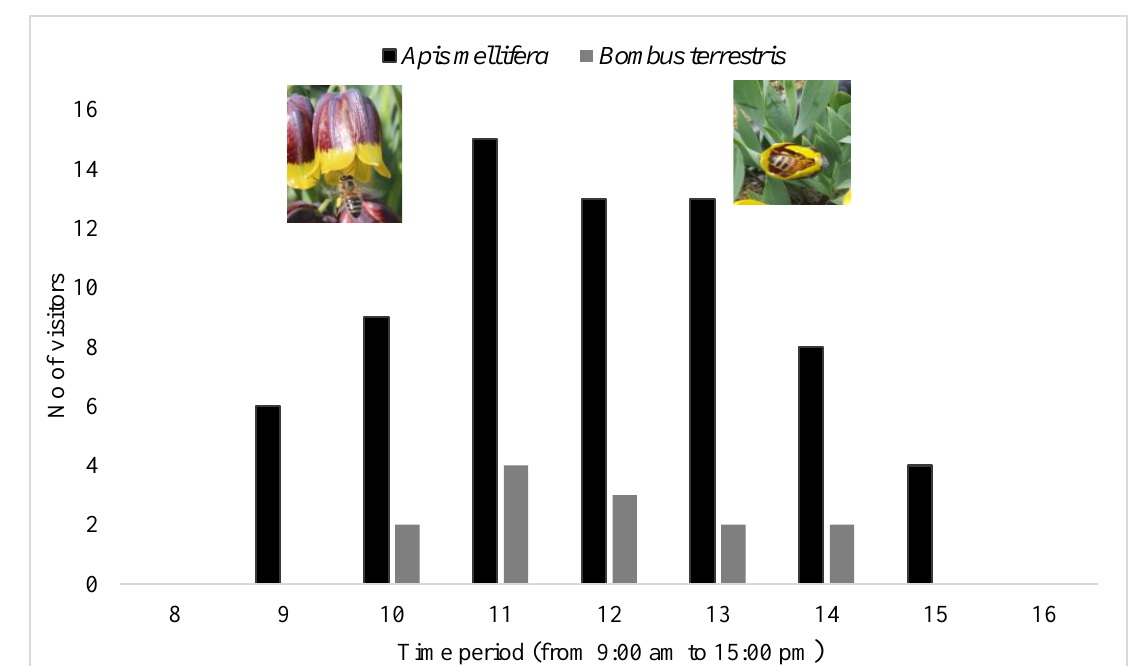
Figure 4. The average number and visiting periods of floral visitors.